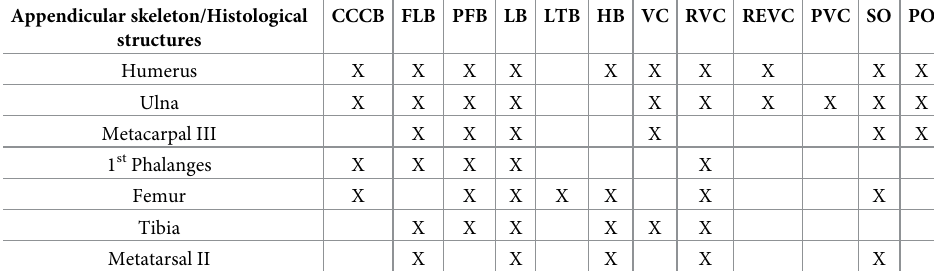
Table 3. Histological structures in the appendicular skeleton of Caraguatypotherium munozi . Abbreviations in Fig 4. Appendicular skeleton/Histological